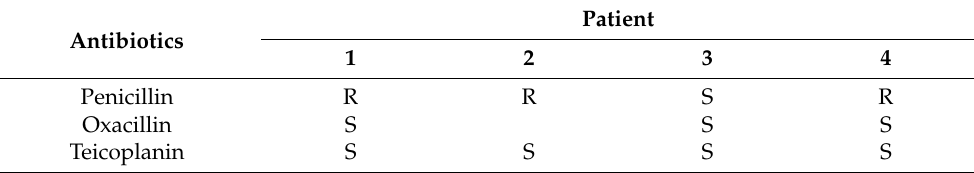
Table 2. Antibiotic susceptibility testing results of Staphylococcus lugdunensis